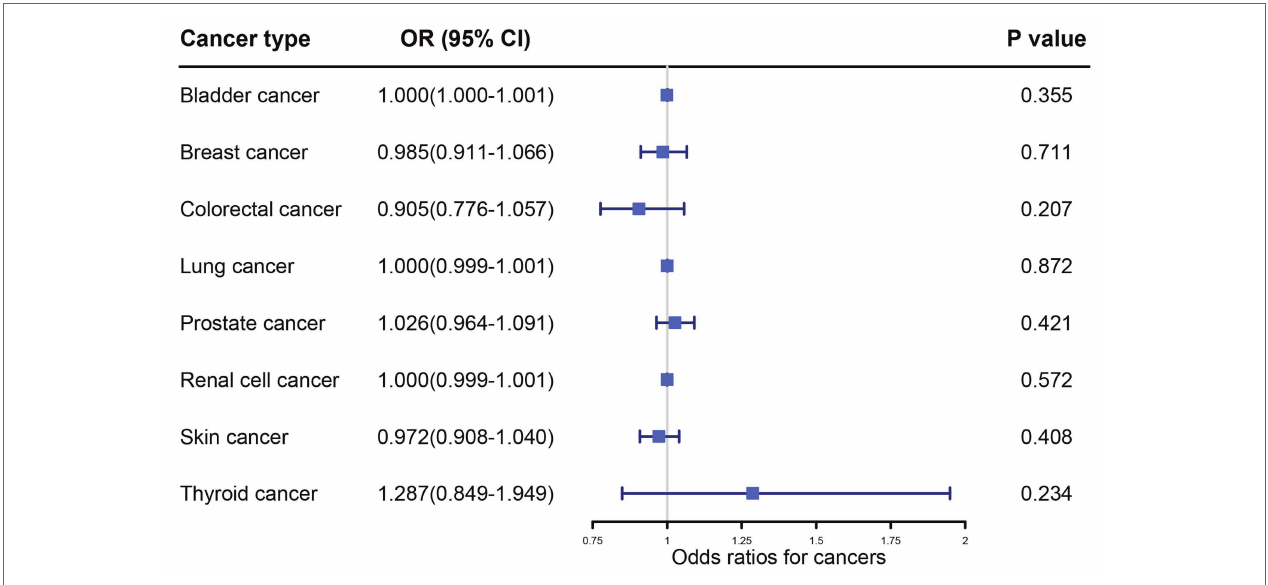
FIGURE 2 | Primary results of the causal associations between serum uric acid levels and cancer risk by random effects inverse variance weighted method. OR, odds ratio; IVW, inverse variance weighted; CI, confidence